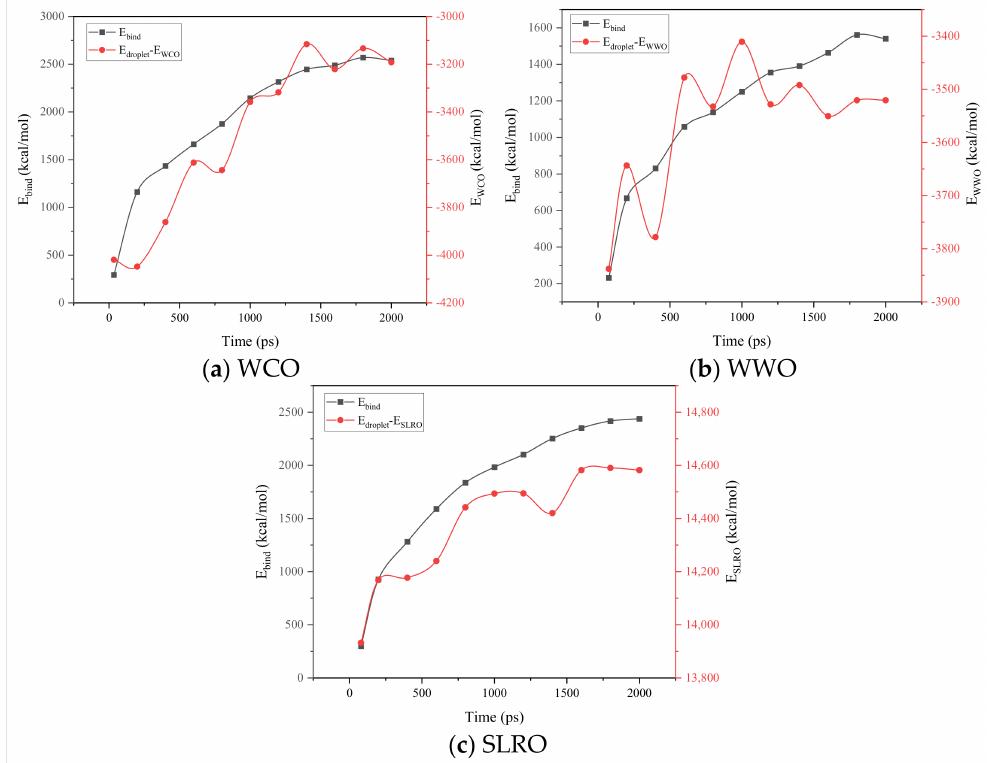
Figure 14. The nonbond interaction energy between the bio-oils droplets and aged bitumen surface, E bind and the energy of the bio-oils droplets E droplet